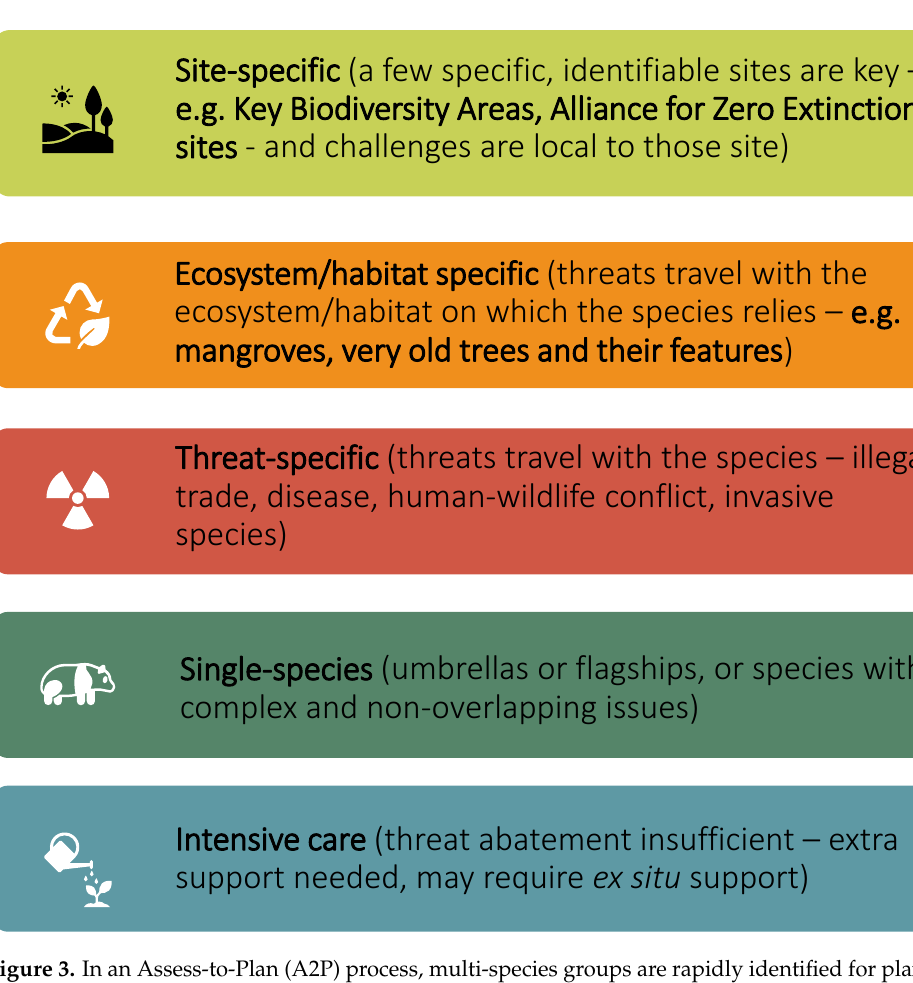
Figure 3. In an Assess-to-Plan (A2P) process, multi-species groups are rapidly identified for planning and action. Effective groupings generally coalesce around these themes, recognizing that a single species may fall into more than one grouping.